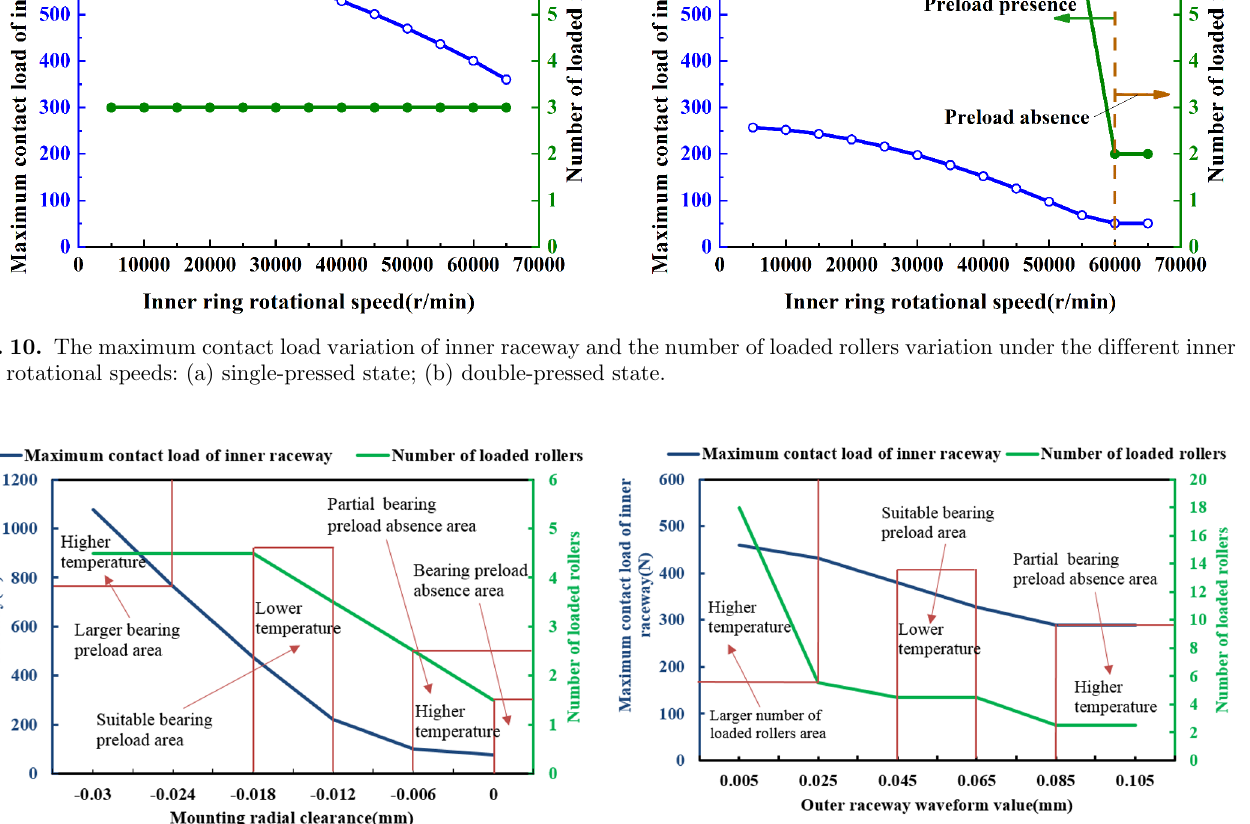
Fig. 11. The preload characteristics and temperature trend predictionofbearingunderthedifferentmountingradialclearances.